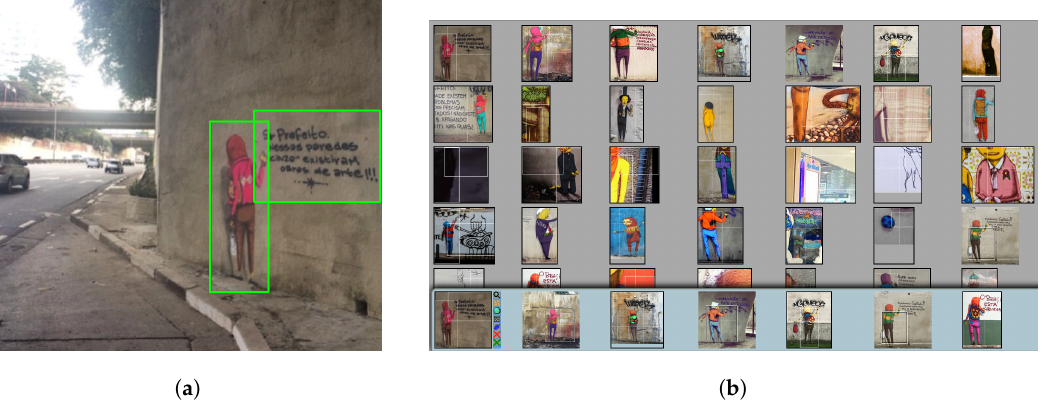
Figure 3. ( a ) Shows the user-selected queries; ( b ) presents the obtained search results after the second training round. Image rights: Computer Vision Group, Heidelberg University. Displayed images are taken from the Instagram page of the artists ’OsGemeos’.